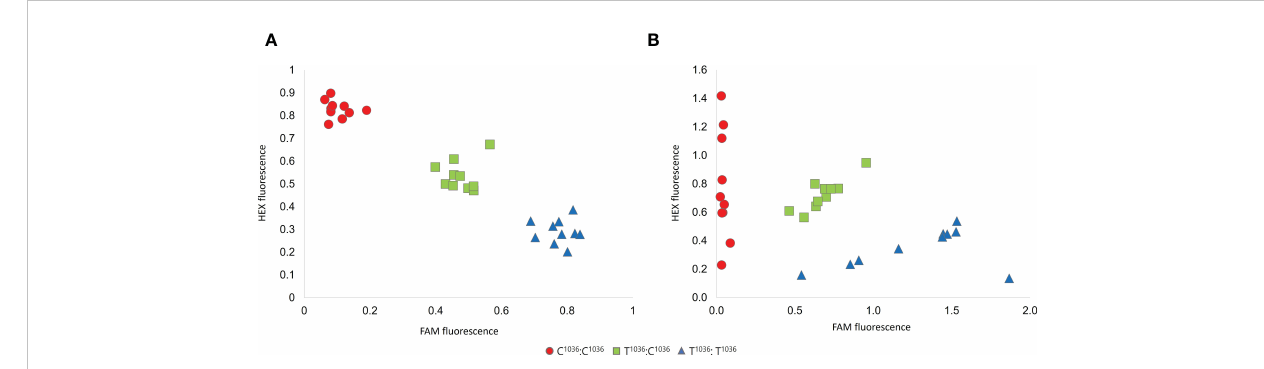
(Supplementary Table 1). Sanger sequencing con fi rmed the C 1036 : C 1036 genotype of these